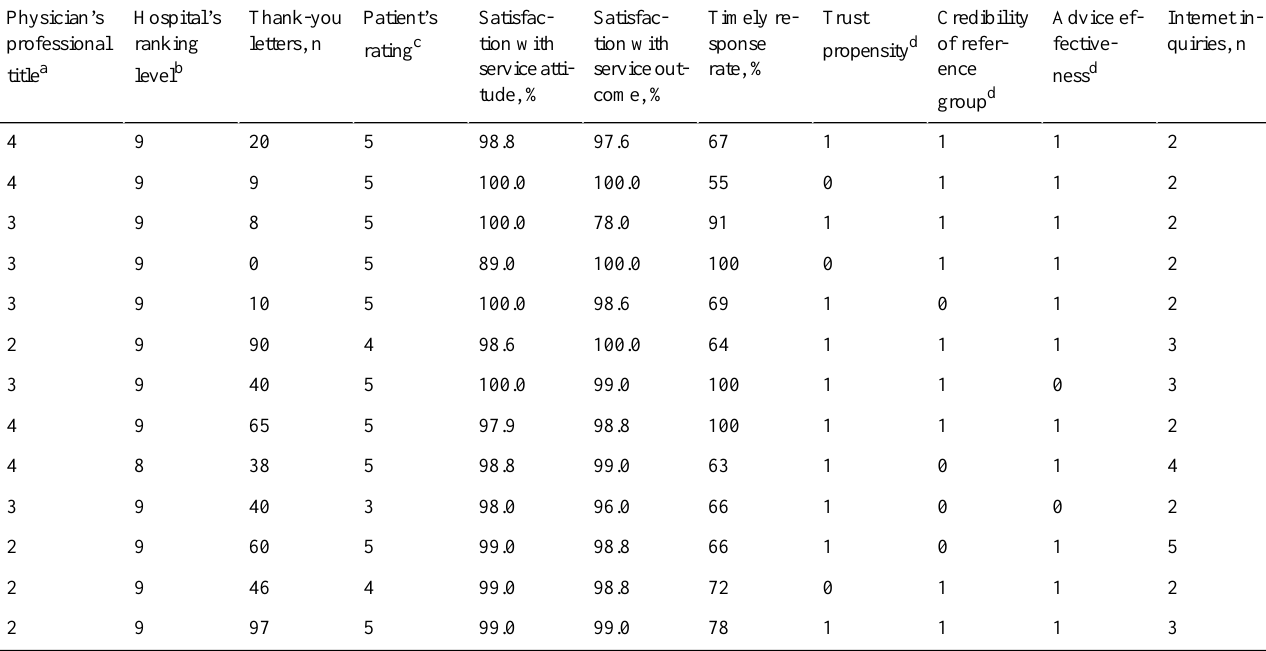
Table 1. Sample of the data obtained for the study.